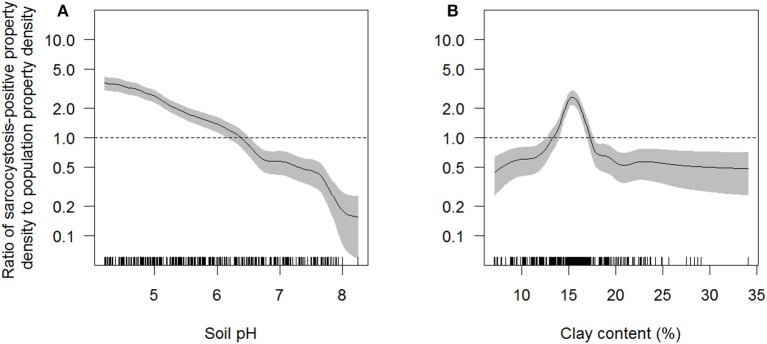
Ratio of sarcocystosis-positive farm density to population farm density as a function of soil pH (A) and clay content (%) in the top 0–5 cm of soil (B) estimated across South Australia using the rhohat procedure. The solid line shows function estimate; gray shading is pointwise 95% confidence band. The vertical dashes along the horizontal axis represent individual data points. The horizontal dashed line represents the null association (density of sarcocystosis-positive farms equals the density of all farms at risk). Interpretation: for those areas in the study area where soil pH was ~5 the intensity of sarcocystosis-positive farms was ~2 times that of all farms at risk. Data represent 4,204 sheep farms that submitted sheep for slaughter during the period 2007–2017.